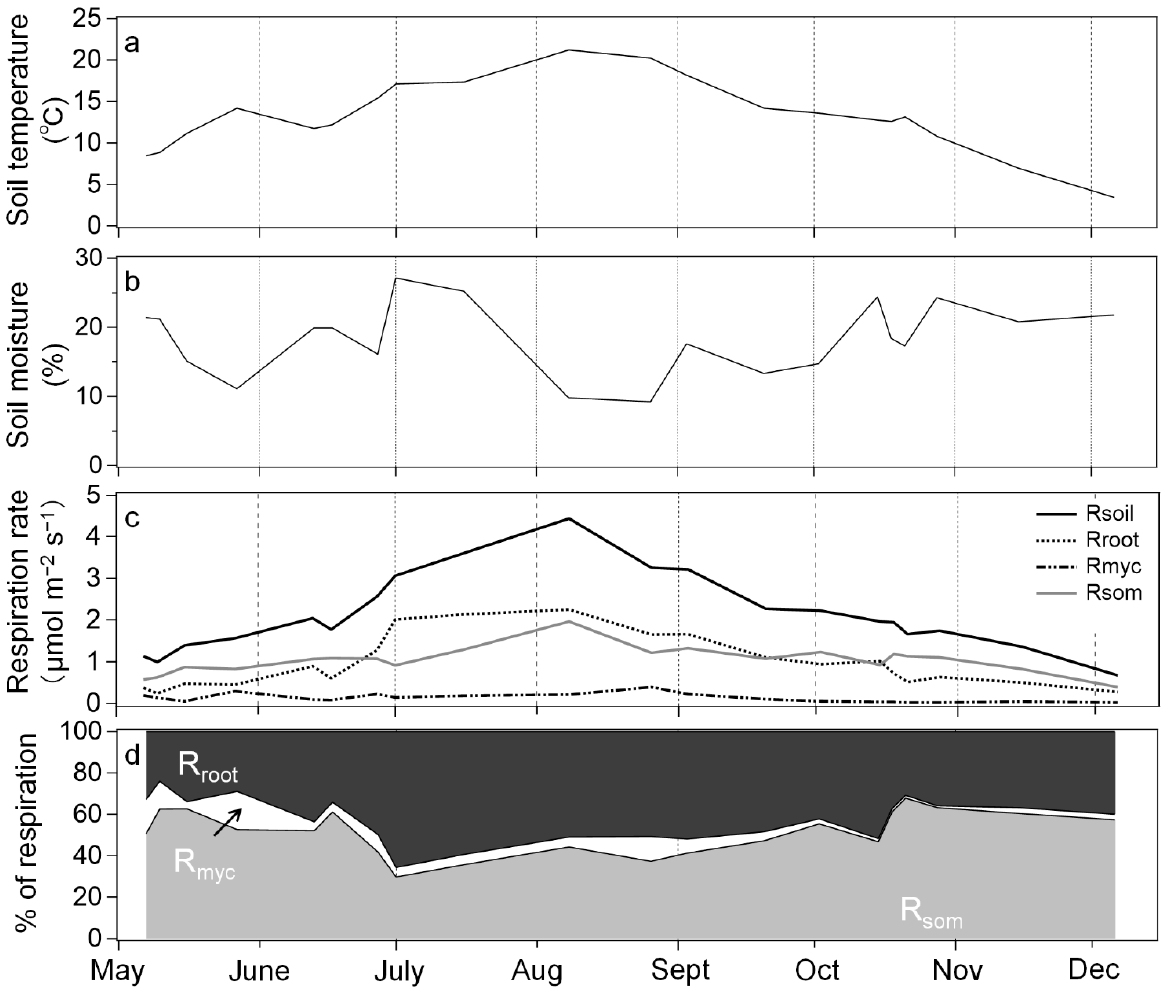
Figure 1. Time courses of ( a ) soil temperature at 0–5 cm depth, ( b ) soil moisture at 0–5 cm depth, ( c ) respiration rates in soil, and ( d ) percentages of different soil respiration components (Root respiration (R root ), mycorrhizal respiration (R myc ), and SOM respiration (R som )) during the months from May to December with non-snowpack period in 2019.